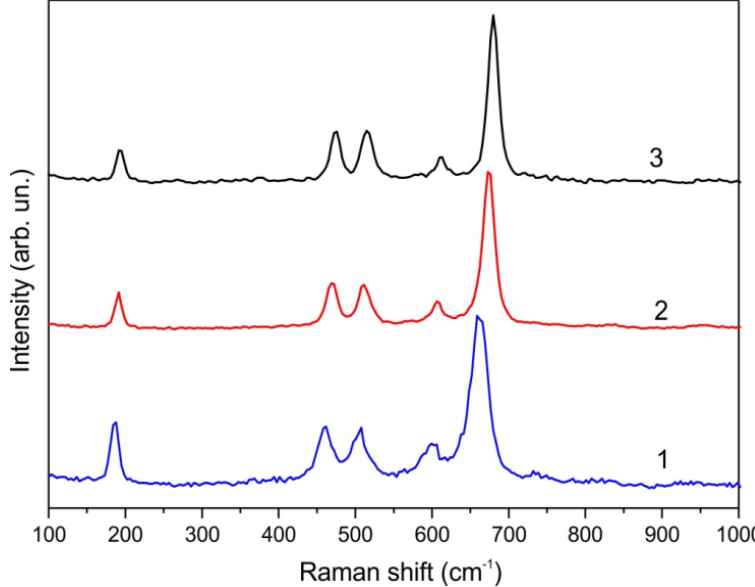
Table 1. Positions of the Raman peaks (cm −1 ) for the samples synthesized at different temperatures T syn compared with the literature data [59].